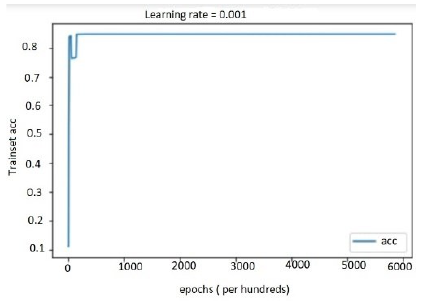
Figure 10. Training accuracy versus epochs for text modality.